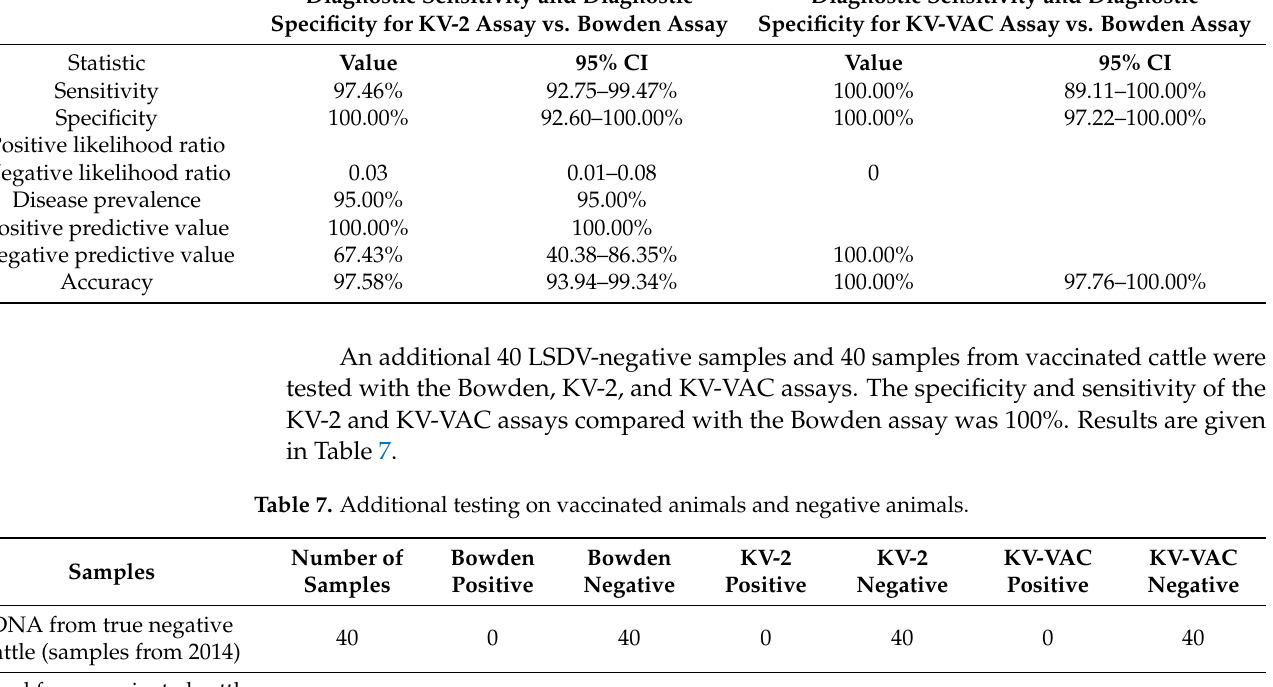
Table 6. Diagnostic sensitivity and diagnostic specificity for the KV-2 and KV-VAC assays vs. Bowden assay. Diagnostic Sensitivity and Diagnostic